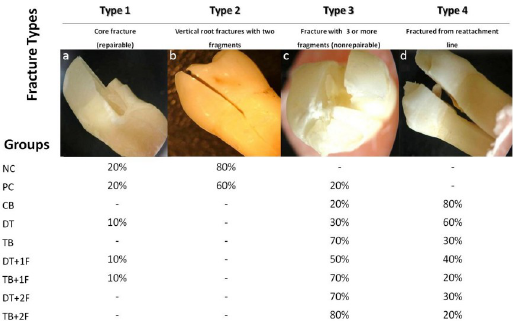
Fig 2. Classification and distribution of fracture types after compressive